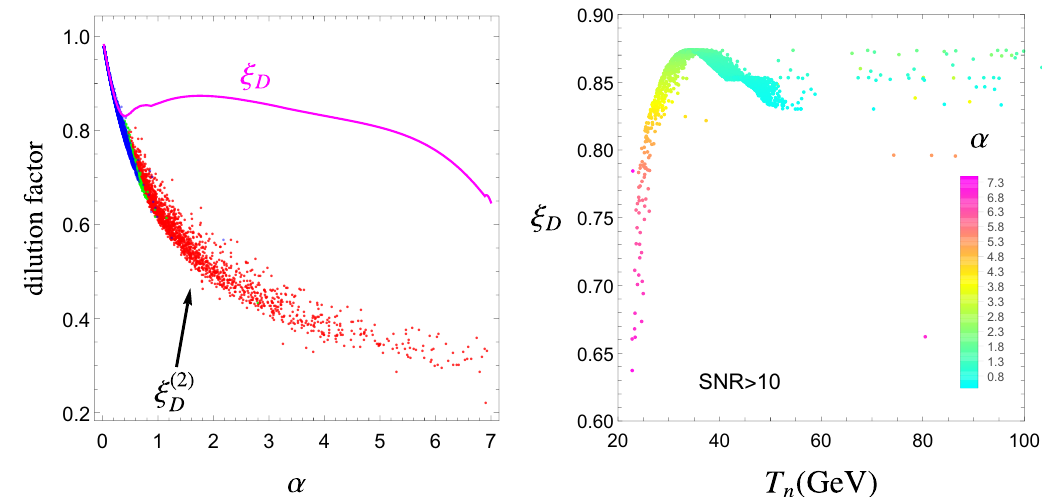
Figure 5 . Figures showing the dilution e(cid:11)ect of the baryon asymmetry. The left panel shows two di(cid:11)erent de(cid:12)nitions of the dilution factor and the right panel shows the dilution factor (cid:24) D de(cid:12)ned in eq. 4.15 versus T n